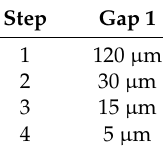
Table 3. Dispersion parameters on the three-roll mill.